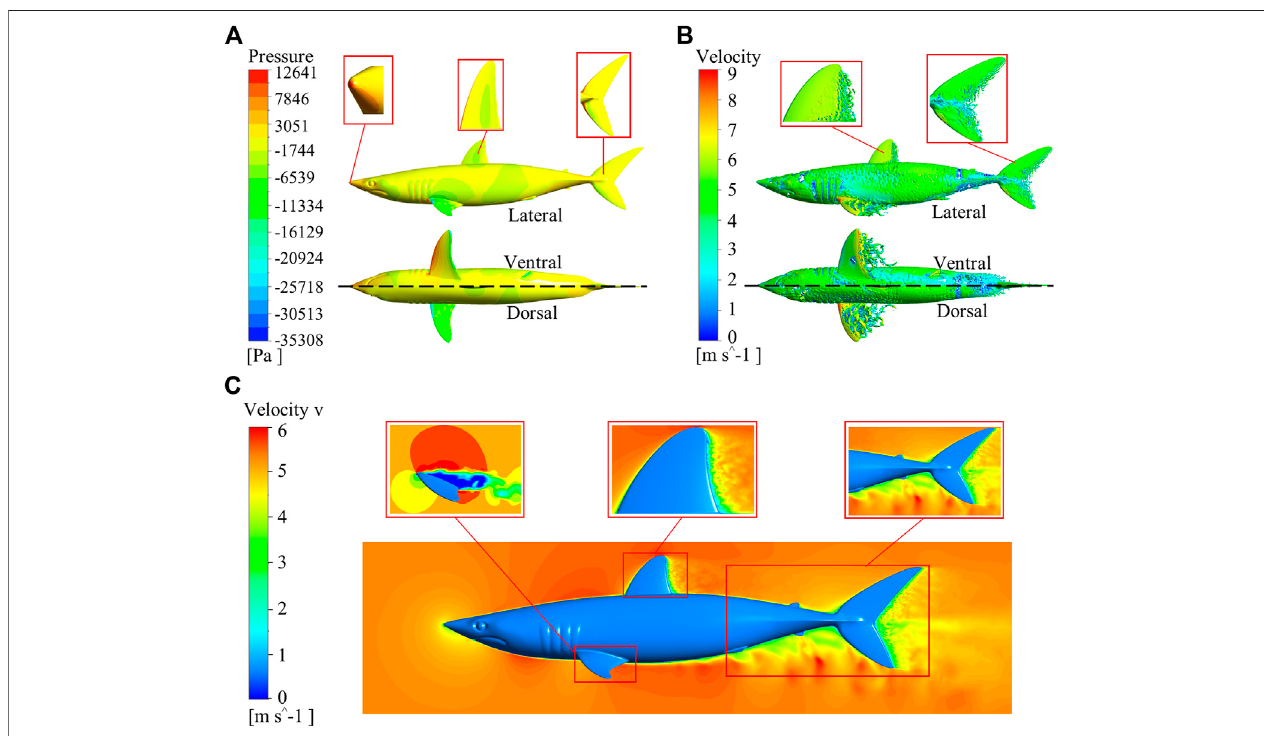
FIGURE 6 | Distributions of pressure, vorticity, and velocity (v component) around the smooth shark model. (A) Pressure distribution, (B) Vorticity distribution; lateral view (upper) and ventral, dorsal views (lower). The inset magni fi ed portions are the nose, fi rst dorsal fi n, and caudal fi n. (C) Distribution of velocity (v component). The enlarged parts are the pectoral fi n, fi rst dorsal fi n, posterior zone of the shark body, and caudal fi